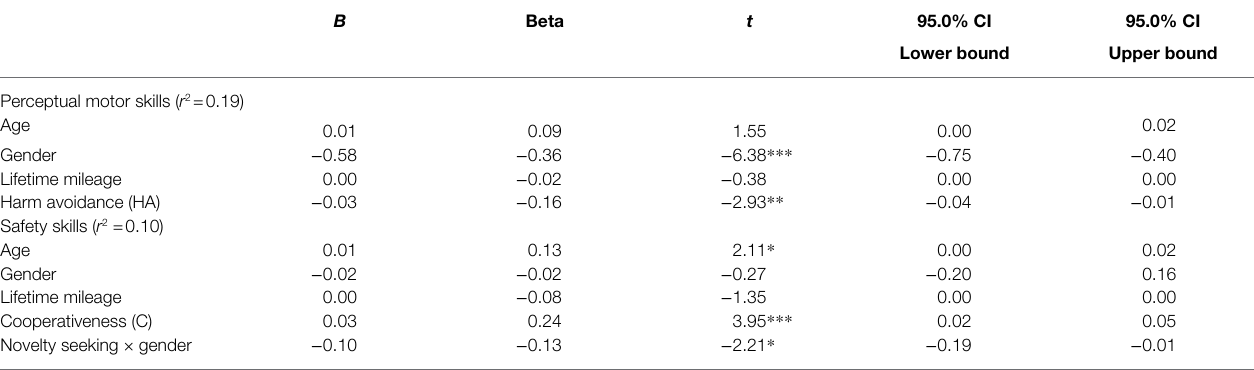
TABLE 4 | Temperament and self-assessed driving skills: regression analysis results for DSI variables as the dependent variable. B Beta t 95.0% CI